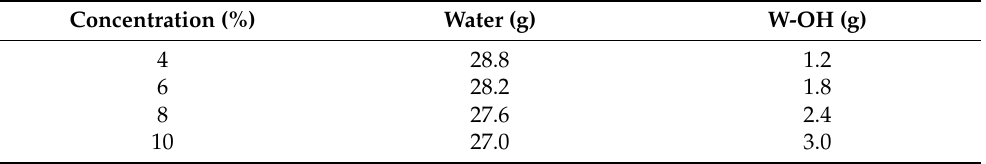
Table 2. Raw material dosage of W-OH films with different concentrations.